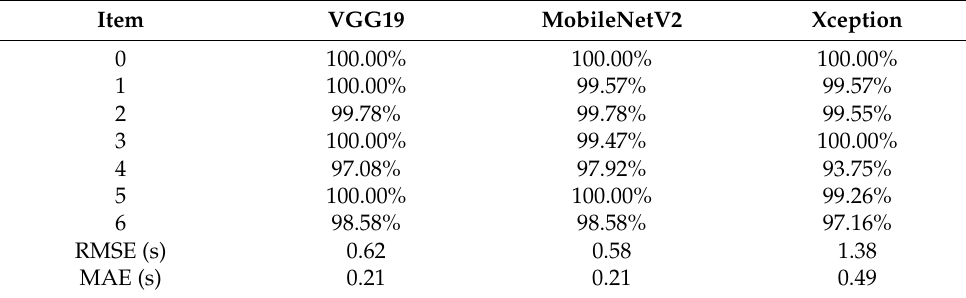
Table 3. Recall rates of the models for the feeding test dataset.